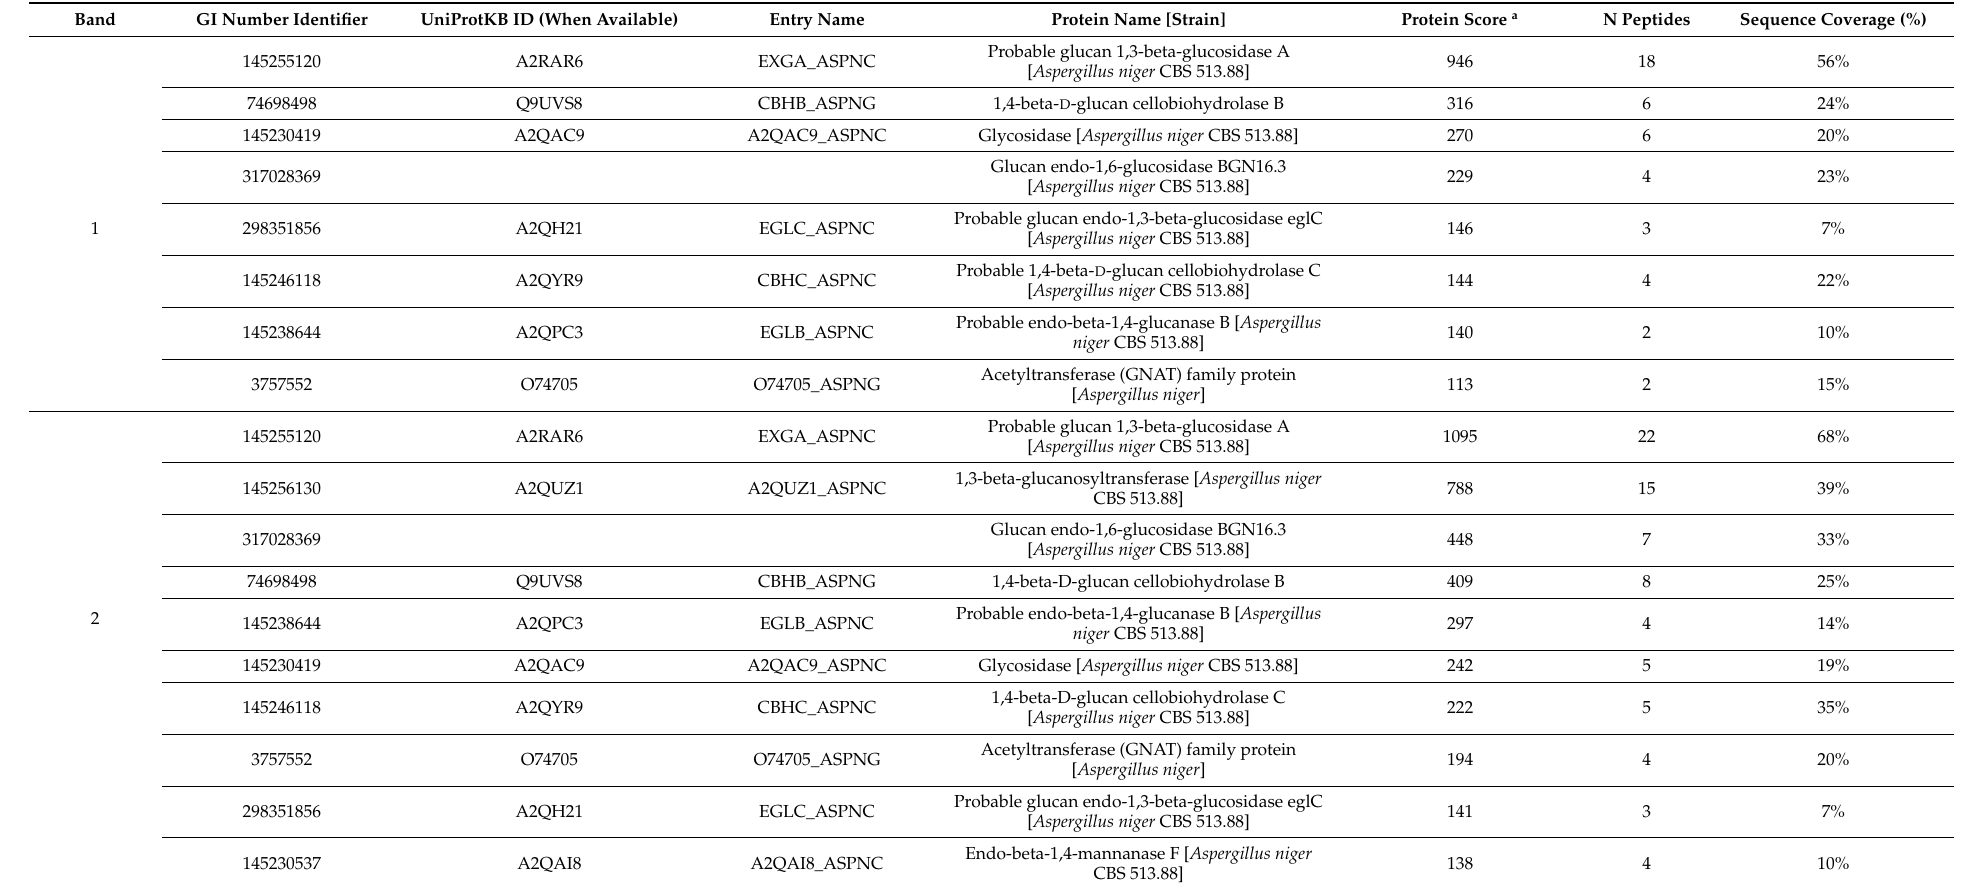
Table 3. Cellulase identified in the supernatant of Aspergillus niger LPB-334 strain. Bands were selected on the basis of zymograms as shown in Figure 7 and excised from the gel, in situ digested with trypsin and the resulting peptide mixtures were analyzed by LC-MS/MS. Band number corresponds to the band selected on the gel. Raw data were used to query the NCBI database with the taxonomic restriction to fungi as described in detail in the Materials and Methods section. Only proteins identified with two or more peptides were considered as confidently identified. Only proteins that have been annotated in the database as being involved in cellulose metabolism have been